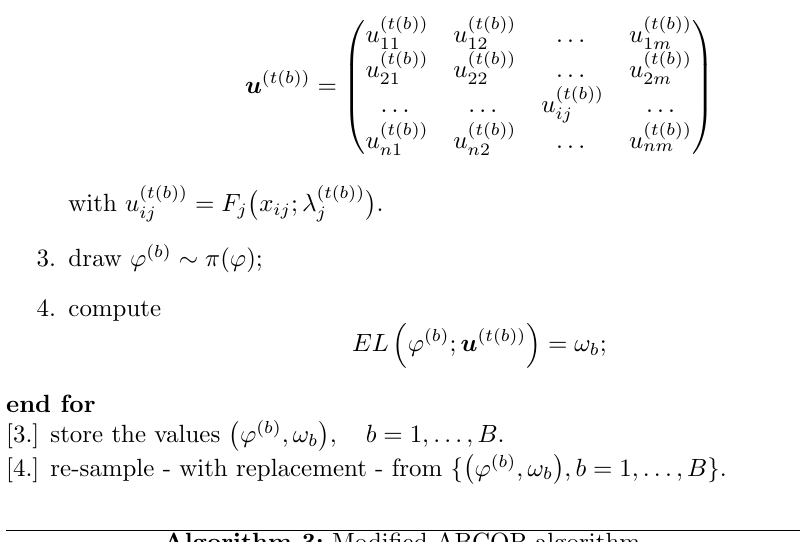
Algorithm 3: Modified ABCOP